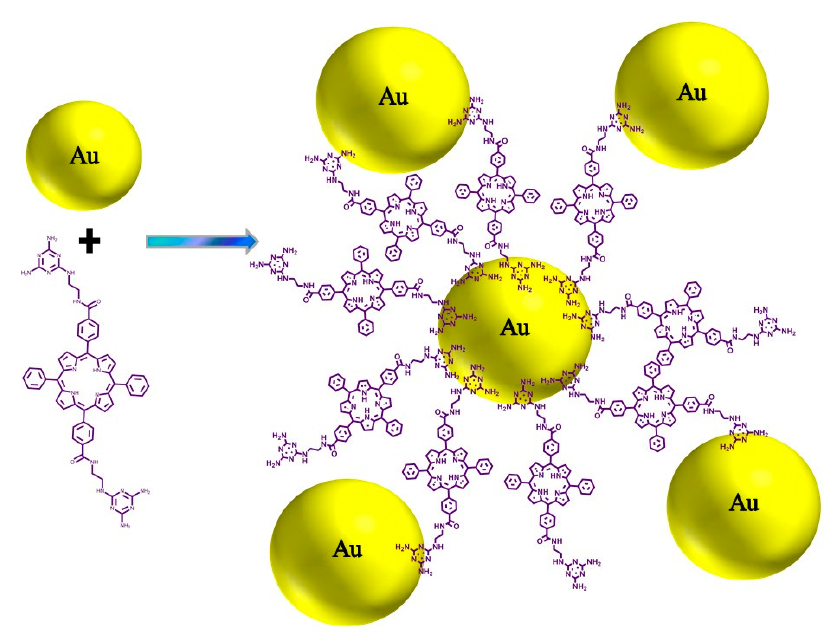
Scheme 2. Reaction pathway for the Au NPs–porphyrin